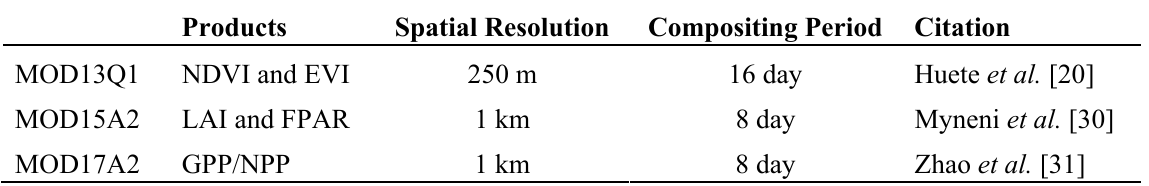
Table 1. Description of Moderate Resolution Imaging Spectroradiometer (MODIS) product